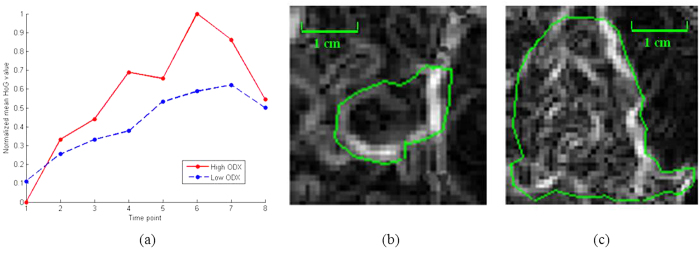
Comparison of contrast enhancement pattern and dynamic histogram of oriented gradient (DHoG) features (4 bins) of estrogen receptor (ER)-positive breast lesions between low OncotypeDX recurrence score (=15), moderate grade in 49-year-old woman and high OncotypeDX recurrence score (=40), high grade in 64-year-old woman.(a) Normalized mean DHoG values versus time points. (b) DHoG feature map of low OncotypeDX at peak enhancement (7th phase, 1.5T). (c) DHoG feature map of high OncotypeDX at peak enhancement (6th phase, 1.5T). The green contour indicates tumor boundary. Note that the two curves have distinct enhancement patterns. Feature maps associated at peak enhancement reflect great intensity variance between two tumors.